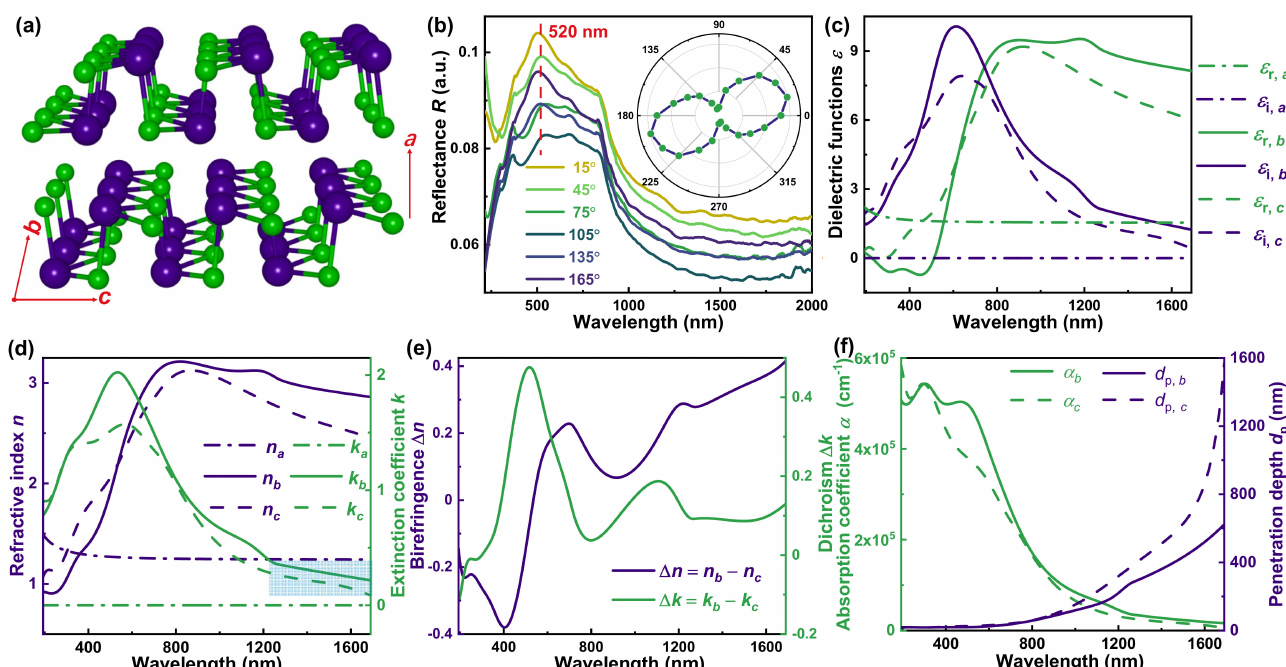
Figure 1. The optical anisotropy of SnSe. ( a ) The low-symmetry lattice structure of SnSe. ( b ) The polarization-resolved reflectance spectra with insert of the corresponding polar coordinate curve at peak wavelength of 520 nm. ( c ) The dielectric tensor, ( d ) the complex refractive index tensor, and ( e ) the derived birefringence ∆ n and dichroism ∆ k of b - c plane of SnSe. ( f ) The absorption coefficient α and the penetration depth d p along the b - and c -axis, respectively, of